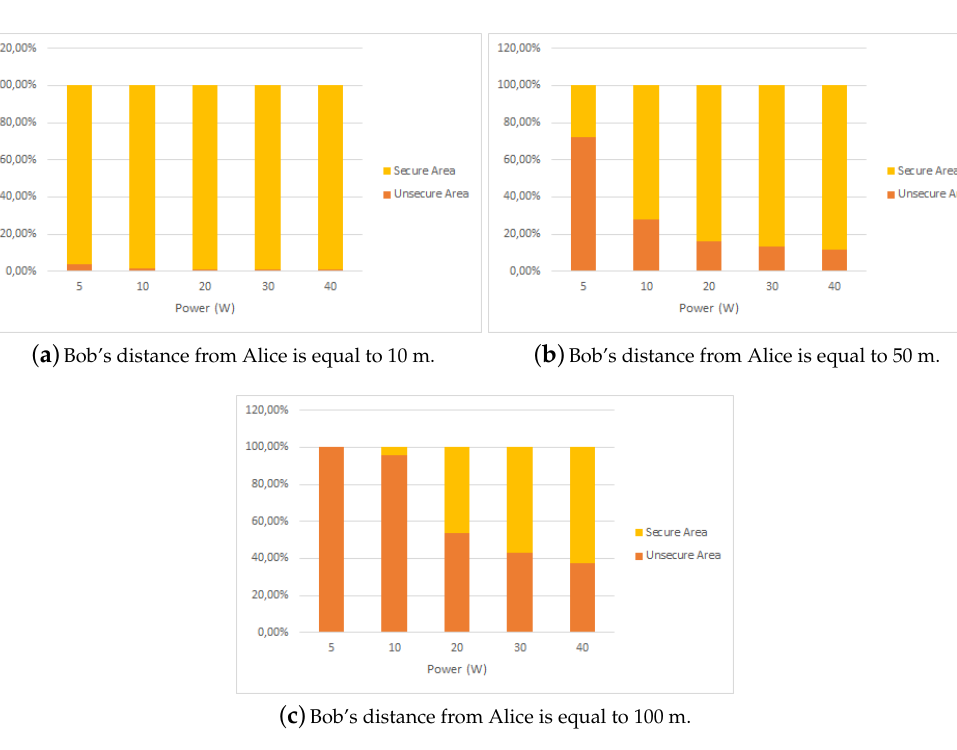
Figure 4. Secure and unsecure areas when Bob’s distance is { 10,50,100 } m and P = { 5,10,20,30,40 }